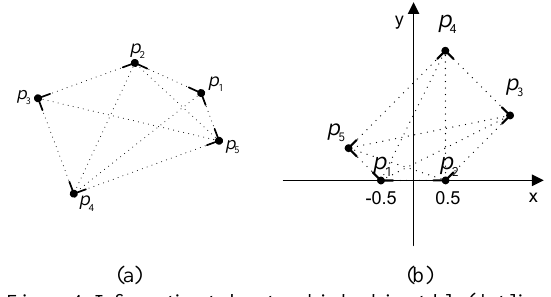
Figure 4. Information to be stored in hashing table (dot lines